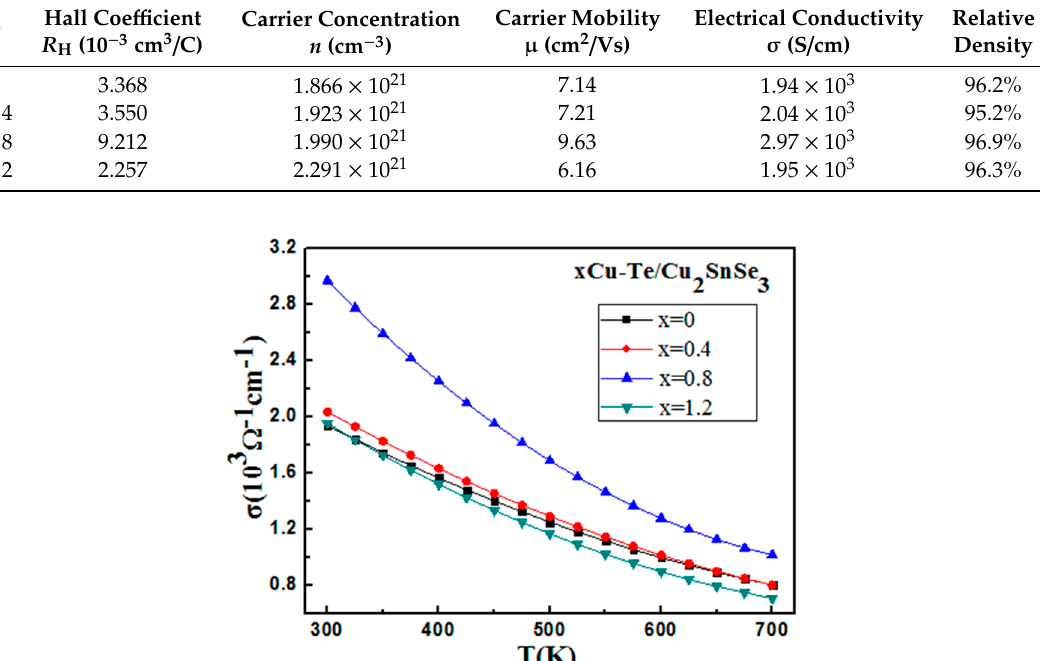
2 SnSe 3 composites.